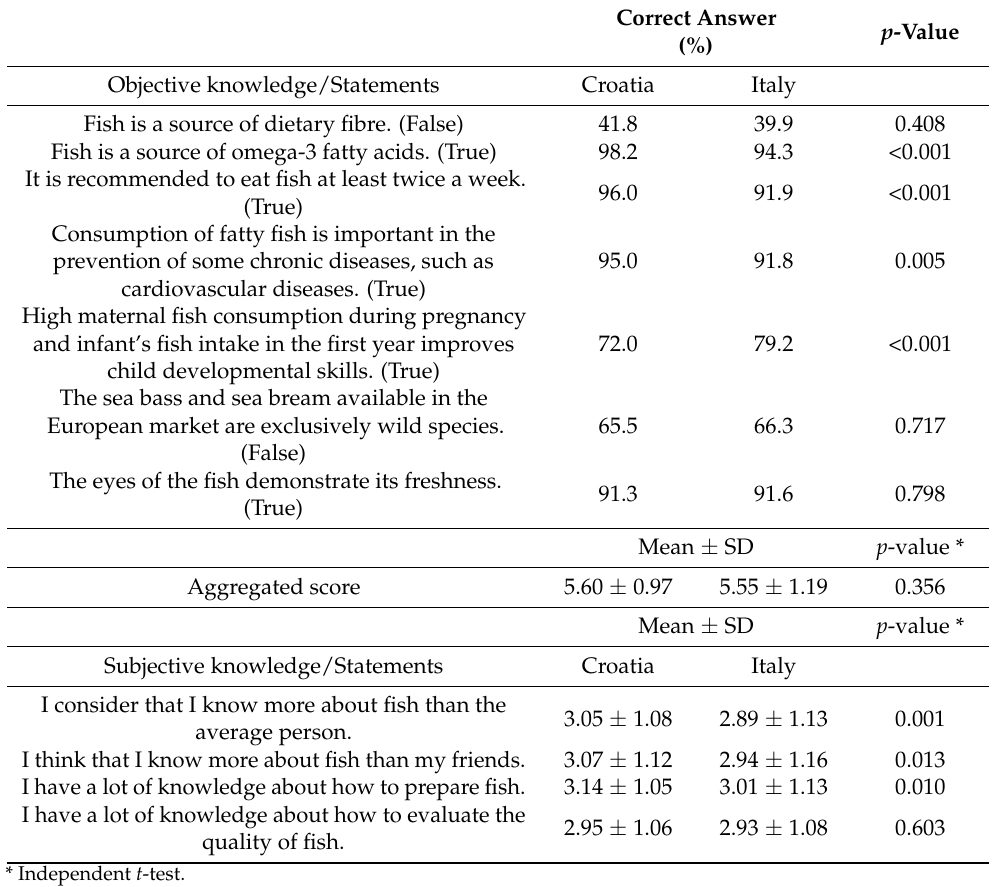
Table 3. Objective and subjective knowledge of study participants in Croatia and Italy.